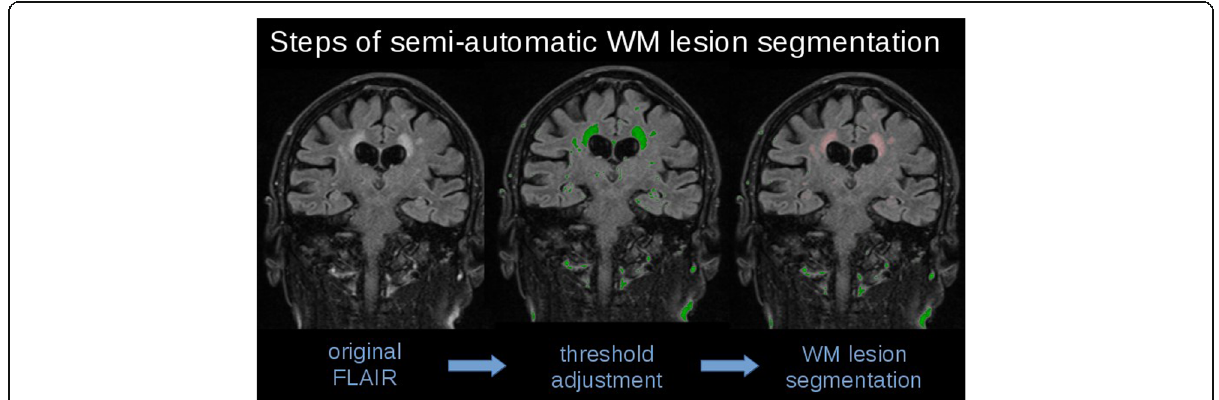
Fig. 1 Steps of semi-automatic white matter (WM) lesion segmentation in one of our patients (central coronal slice): Lesions in the original fluid- attenuated inversion recovery (FLAIR) image appear as hyperintensities. After threshold adjustment (green voxels), WM lesions could be segmented (light red voxels)